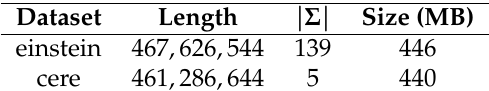
Table 1. Summary of